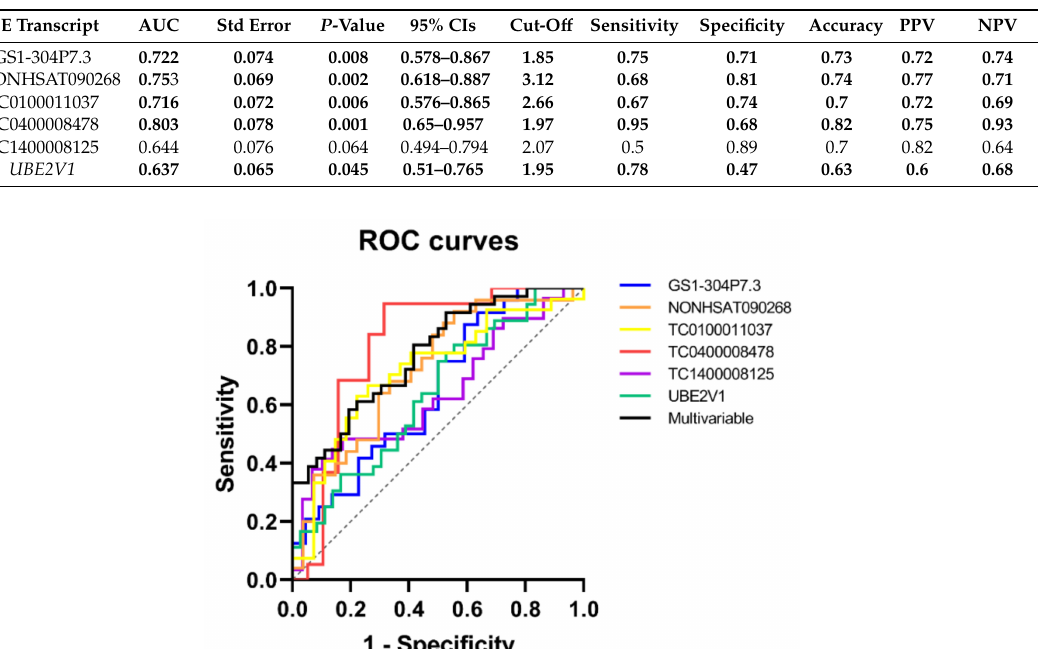
Table 2. Results of univariable ROC (receiver operating characteristic) curve analysis. For each transcript, the p -value of the curve, the area under the curve (AUC), its standard error (Std error), and the 95% confidence intervals (CIs) are shown; the Youden index was also calculated to identify the optimal cut-o ff , for which sensitivity, specificity, accuracy, positive predictive value (PPV) and negative predictive value (NPV) are shown. Significant values are highlighted in bold.